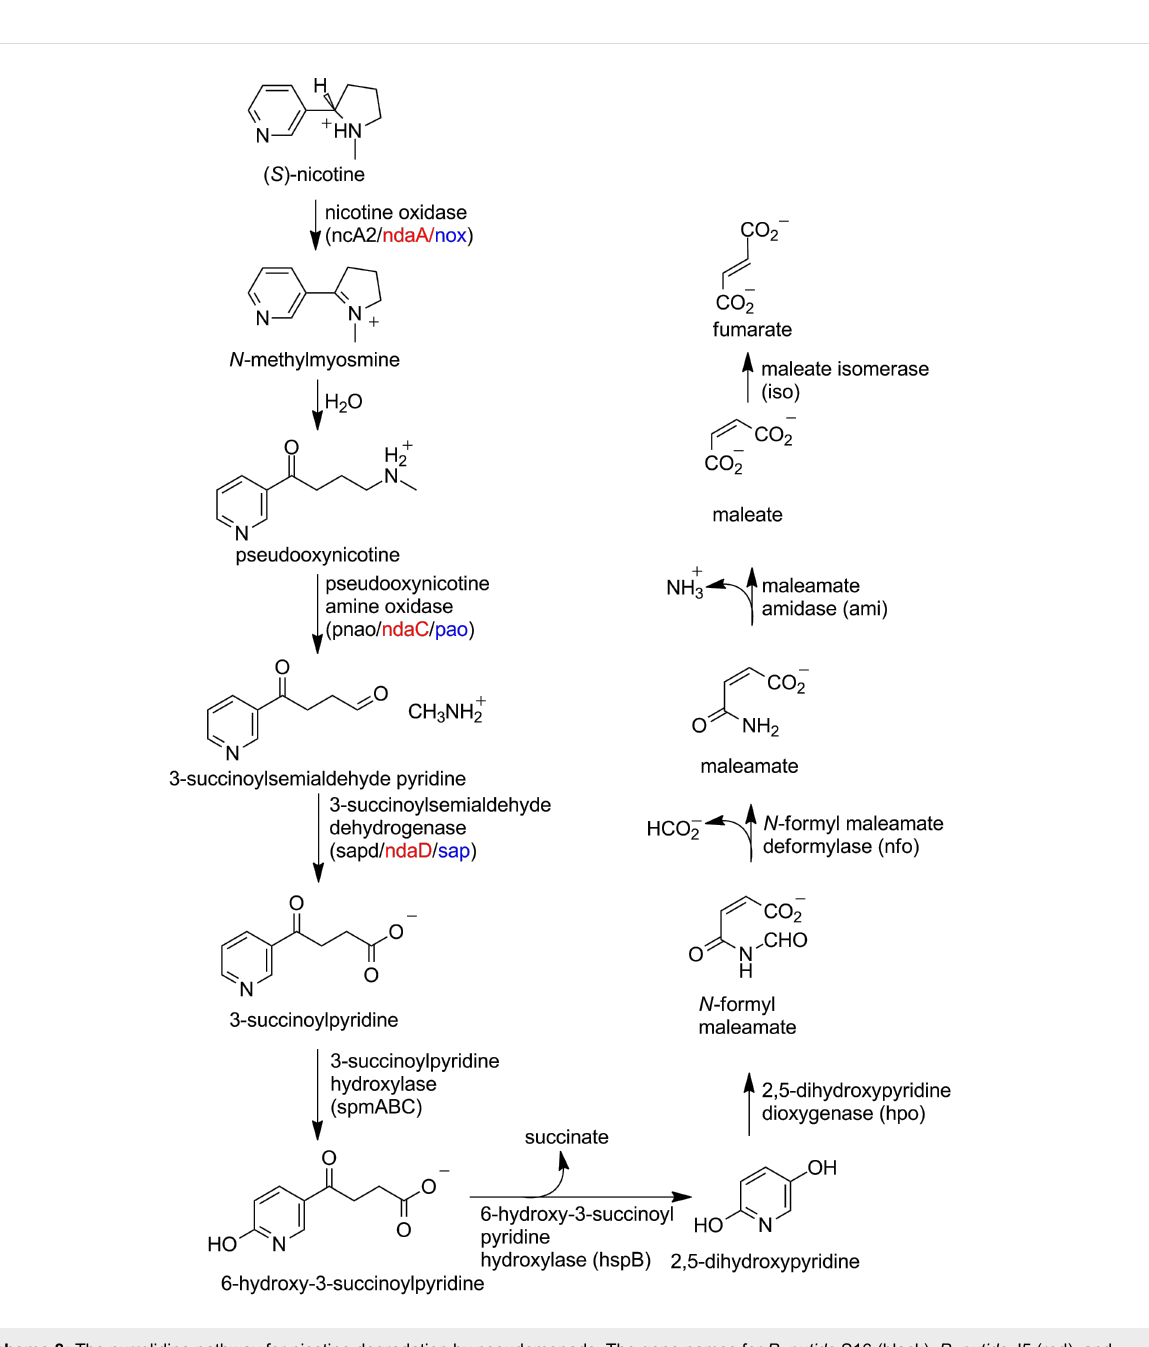
scribed as the pyrrolidine pathway. The initial oxidation of the pyrrolidine ring is catalyzed by the enzyme nicotine oxidase. In P. putida S16, the nicA1 and nicA2 genes produce separate en- zymes that are both reported to have the ability to catalyze this reaction [48]. NicA1 was also reported to catalyze the subse- quent oxidation of pseudooxynicotine to 3-succinylpyridine and methylamine, but no kinetic parameters for the two reactions were reported [51]. However, deletion of nicA2 but not of